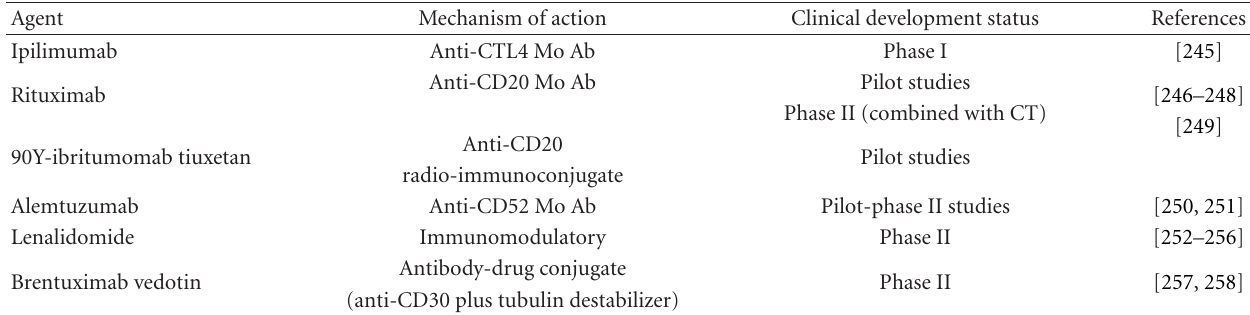
Table 2: Clinical experience with new immunotherapies in Hodgkin